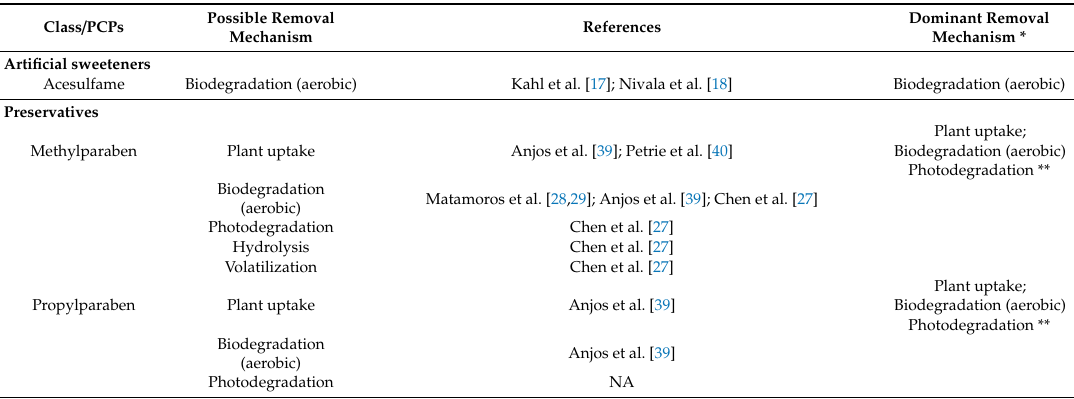
Table 3. Removal mechanisms of 15 widely studied PCPs in